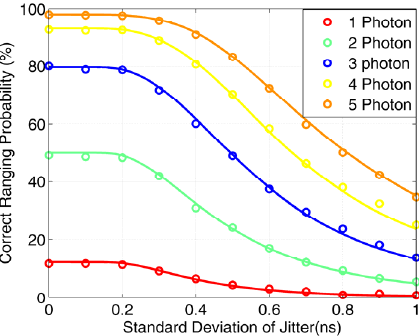
Figure 7. The influence of jitter on correct ranging probability under different echo photons number.